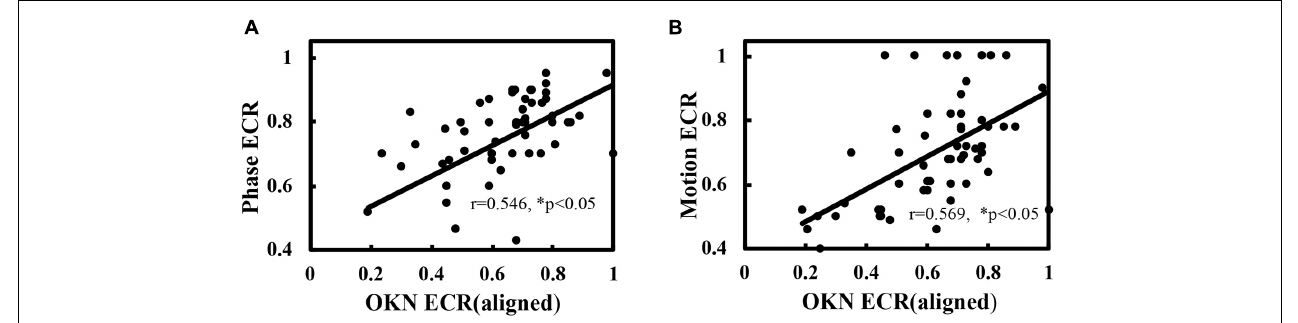
FIGURE 6 | Correlation of the dOKN test with phase and motion tests in IXT subjects when aligned. (A) The visual suppression results of the dOKN test were positively correlated with that of the phase test. (B) The visual suppression results of the dOKN test were positively correlated with that of the motion test. *Represented statistical correlation.